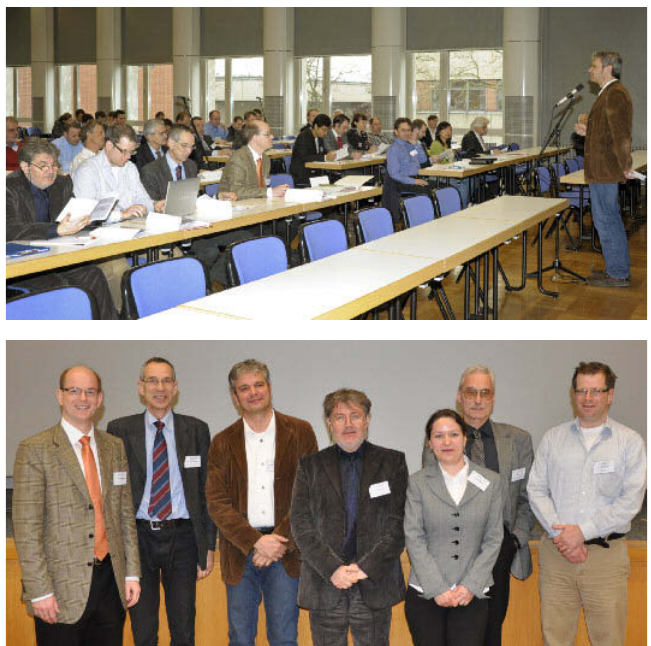
Figure 1 (above): The Annual Meeting of the German Rheolo- gical Society took place at the BAM Federal Institute of Materials Research and Testing in Berlin (Photography by Ulrike Rockland, BAM Federal Institute for Materials Research and Testing). Figure 2: Ute Keßner received the award of the DRG in 2011. From right to left: C. Wagner, C. Marotz- ke, U. Keßner, C. Balan, N. Willenbacher, O. Hassager, and U. Handge (Photography by Lothar Buchta, BAM Federal Institute for Materials Research and